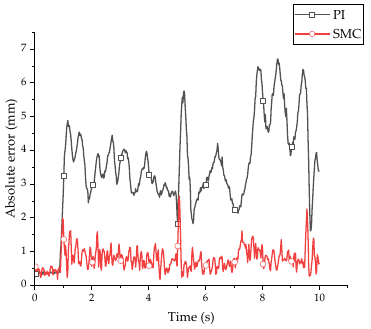
Figure 9. Absolute error comparison between the two control schemes graph.